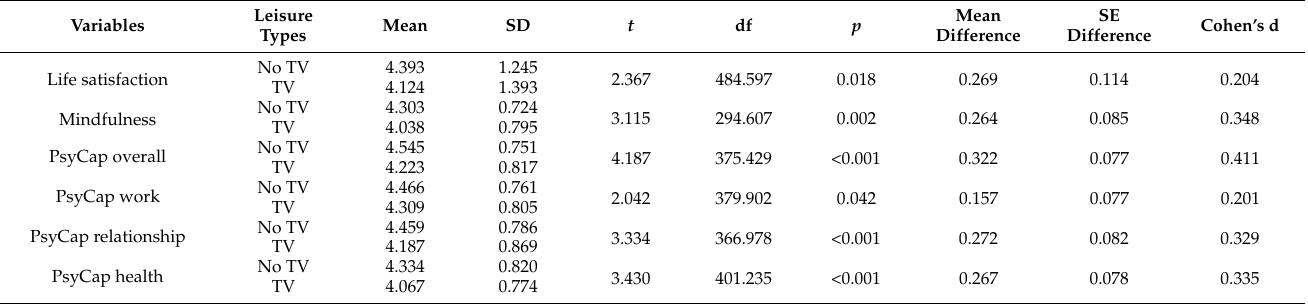
Table 8. Comparison (Welch’s t -test) of life satisfaction, mindfulness, and psychological capital in groups of respondents who prefer and do not prefer